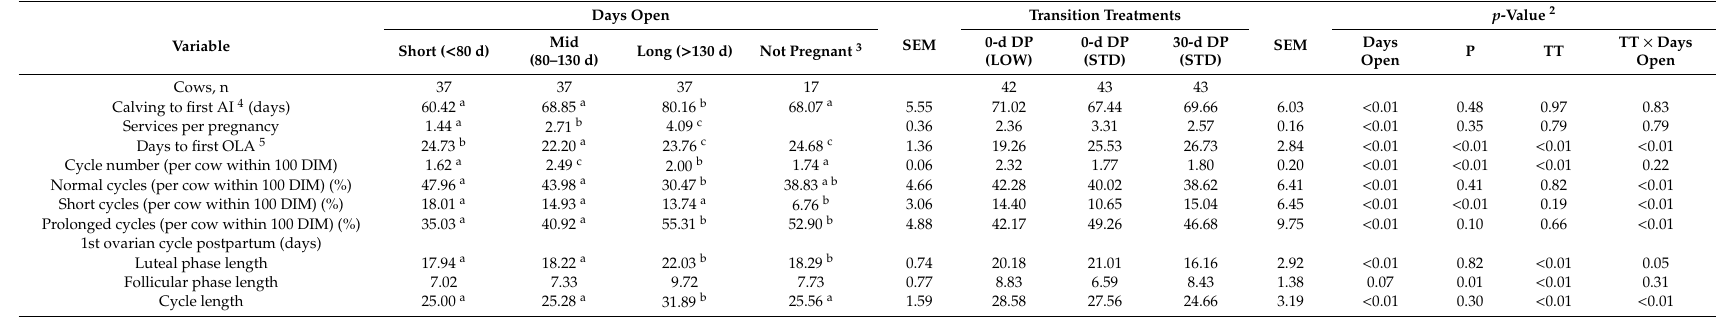
Table 3. Relationship between days open and characteristics of ovarian cycles of dairy cows with di ff erent transition treatments 1 . Days Open Variable